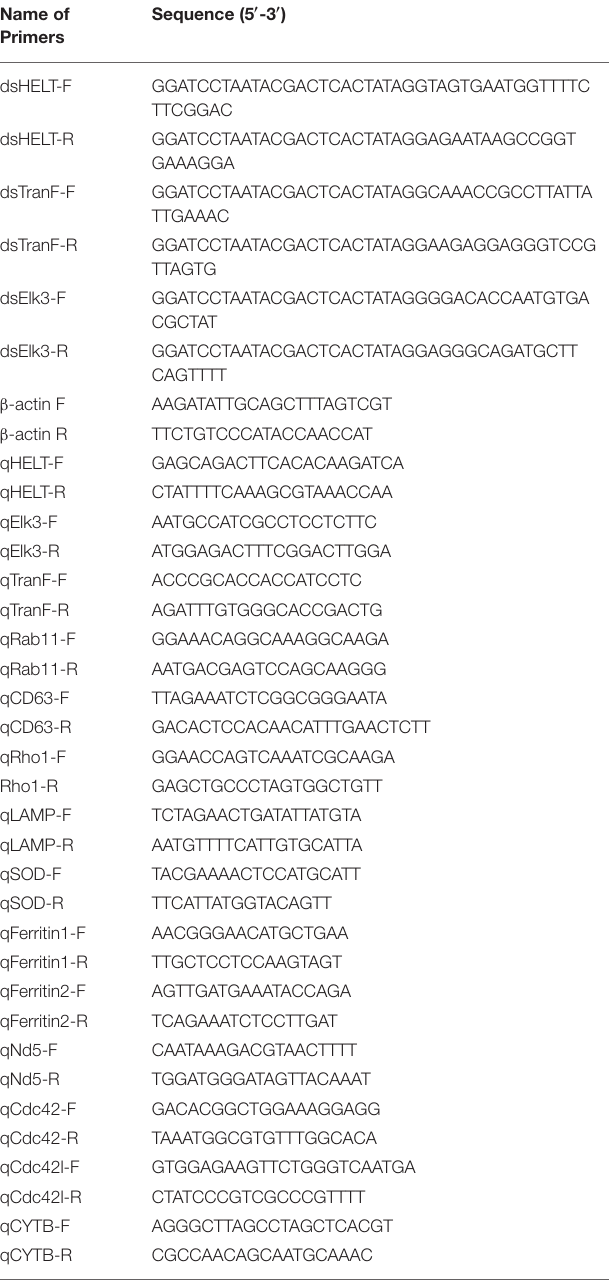
TABLE 1 | Primers used in this